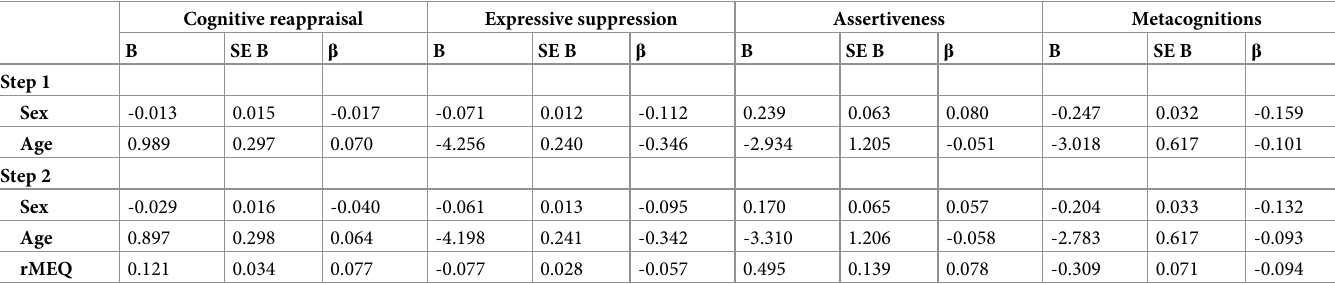
Table 4. Multiple linear regression model coefficients for emotion regulation strategies, assertiveness and MCQ-30 total